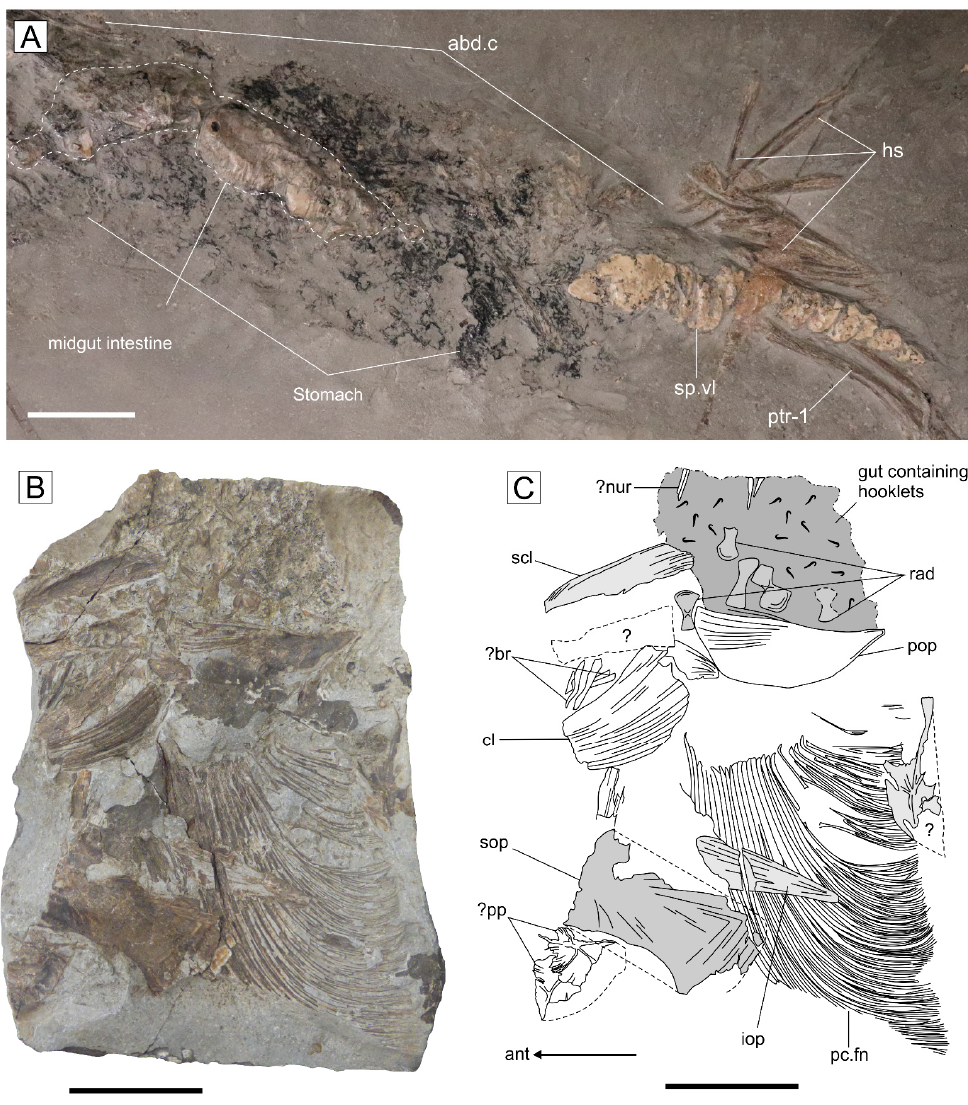
Figure 8. Gastric contents and alimentary canal in Germanostomus pectopteri gen. et sp. nov.: ( A ) Abdominal cavity of SMNS 15815 (holotype) preserving the phosphatized midgut intestine and the spiral valve of the alimentary canal. The black cloud infilling the abdominal cavity likely represents the stomach periphery. ( B , C ) Photograph ( B ) and interpretive line drawing ( C ) of the paratype concretion (SMNS 56344), preserving the left pectoral fin in addition to disarticulated elements of the operculum, pectoral girdle, neural spines, and possibly elements of the skull roof. Remnants of the gut situated dorsal to the pectoral fin preserve abundant coleoid hooklets. abd.c, abdominal cavity; ?br, branchiostegal rays; cl, cleithrum; hs, haemal spines; iop, interopercle; ?nur, neurals; pc.fn, pectoral fin; pop, preopercle; ?pp, postparietals; ptr-1, first anal pterygiophore; rad, radials; scl, supracleithrum; sop, subopercle. Scale bars = 50